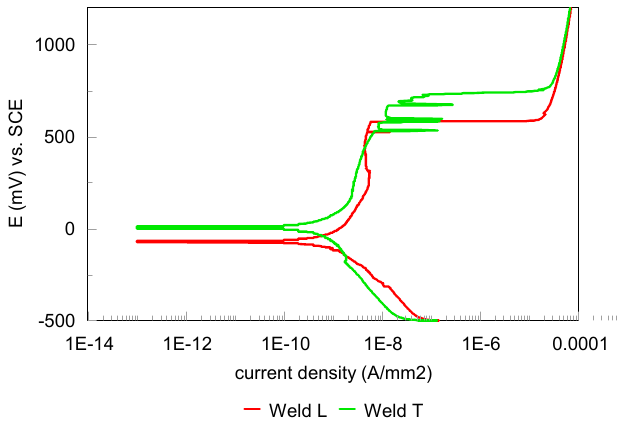
Figure 20. Comparative presentation of the average scanning curves of the weld in the longitudinal (L) and transverse (T) directions of the assembly. Sample #8.